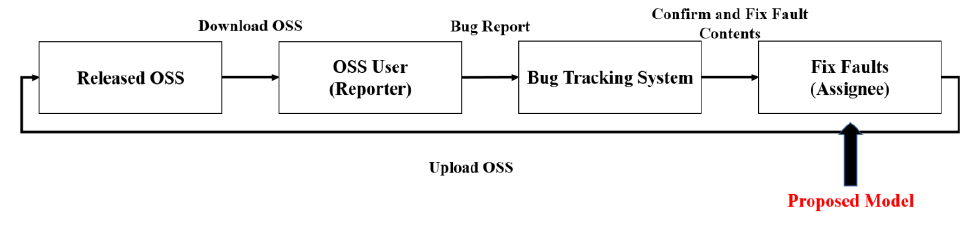
Figure 1. The OSS development using bug tracking